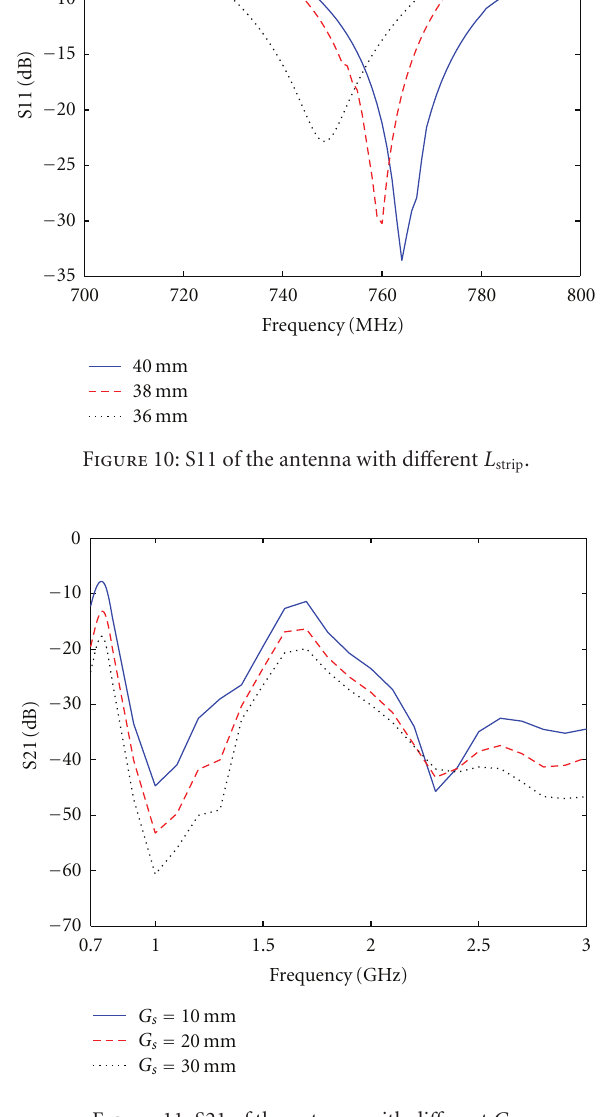
2400 MHz, and 2600 MHz. The antenna 1 has an omnidi- rectional vertically polarized pattern in x - z plane and the antenna 2 generates horizontally polarized radiation in y - z plane. The omnidirectional patterns can enhance and in- crease the channel capacity [6]. Thus the proposed antenna is more attractive for MIMO